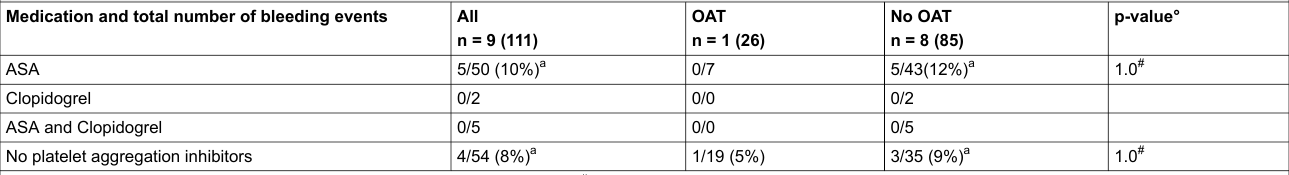
Table 6: Number of bleeding events stratified by platelet aggregation inhibitors (PAI) and oral anticoagulation therapy (OAT) status. Medication and total number of bleeding